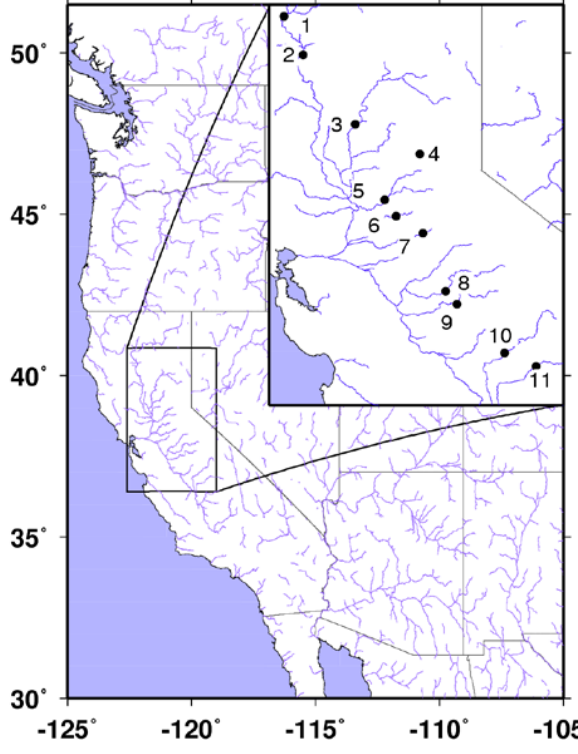
Fig. 1. Location map of the 11 streamflow gauges listed in Table Figure 1. Location map of the 11 streamflow gauges listed in Table 1.2